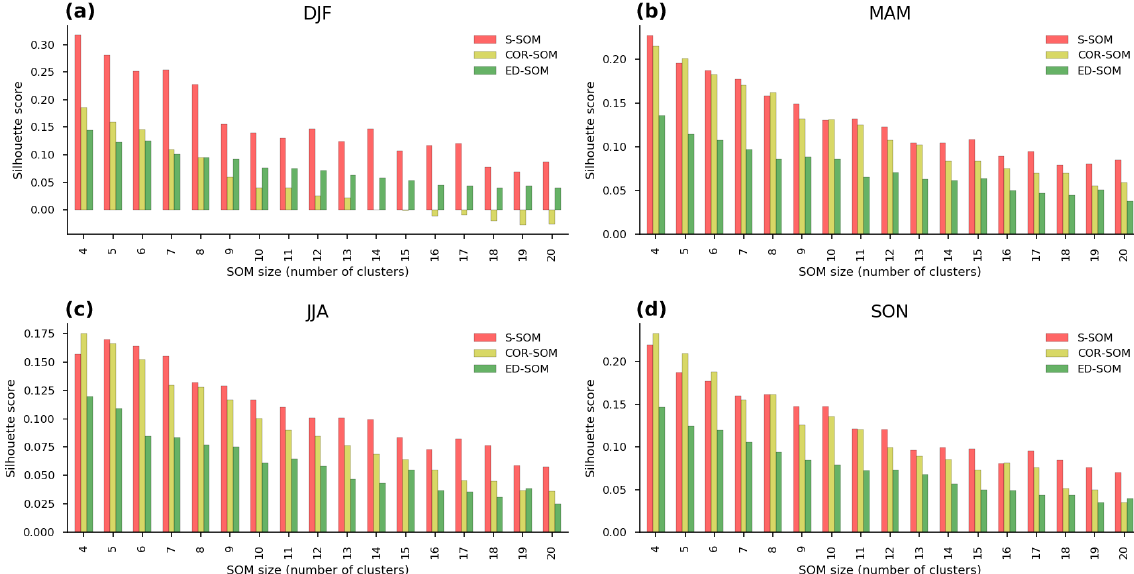
Figure 6. Comparison of silhouette scores of S-, COR-, and ED-SOM for all SOM size configurations and four seasons, i.e., DJF, MAM, JJA, SON. In each plot, the x axis indicates a different SOM simulation (size configuration), and the y axis indicates silhouette score values.